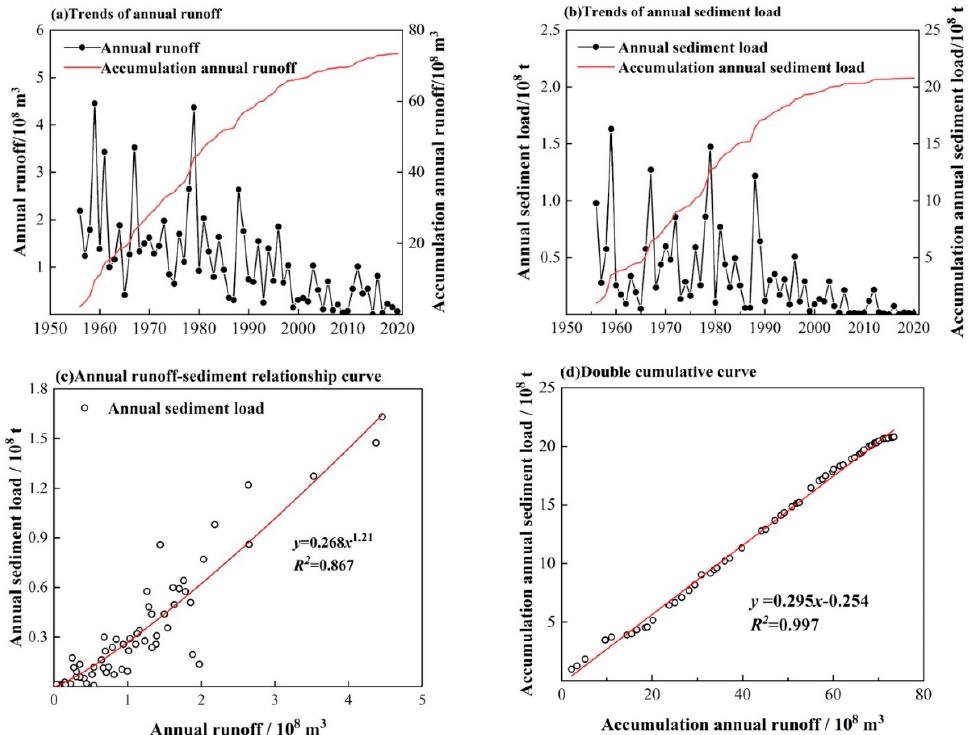
Figure 3. Change in annual runoff and sediment load in the Huangfuchuan Watershed: ( a ) annual runoff trends, ( b ) annual sediment load trends, ( c ) annual runoff-sediment relationship curve, and ( d ) double cumulative curve of cumulative annual runoff-sediment load.